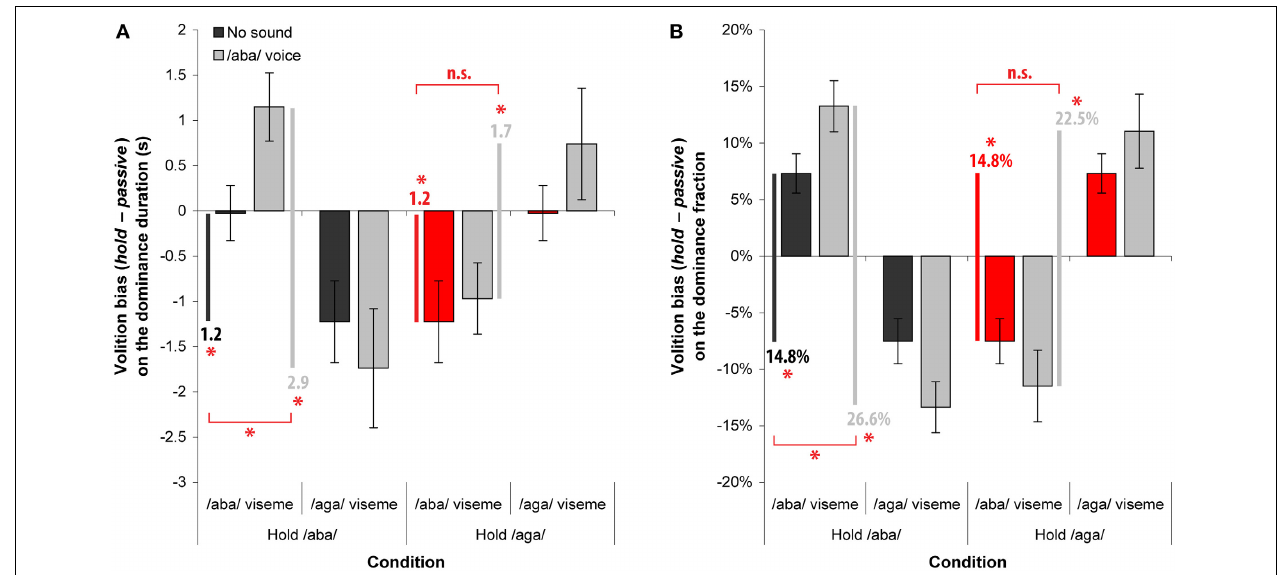
FIGURE 4 | Volition biases on the dominance duration (A) and fraction (B). For each visual percept, the volition bias is the difference in performance between the volition condition and the associated passive condition. Each plot shows the volition biases obtained without sound (from Experiment B) and with the /aba/ voice (from Experiment C) for each rivaling viseme when holding /aba/ or when holding /aga/. Red bars indicate the reference used without sound for the hold /aga/